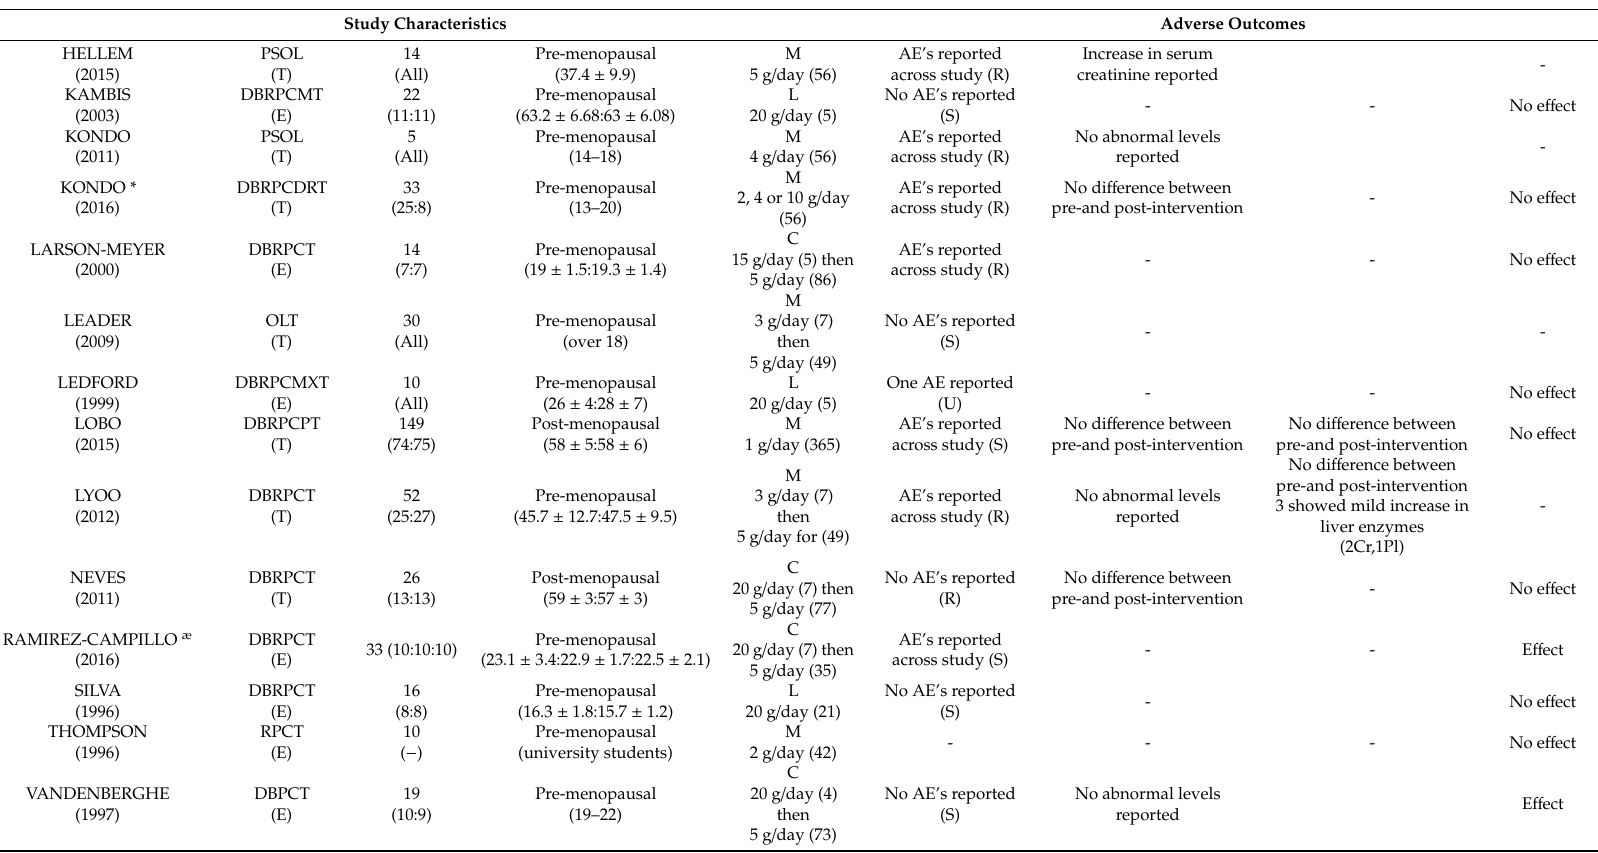
Study Design: DBPCMT = Double blind placebo-controlled matched trial; DBPCT = Double blind placebo-controlled trial; DBRPCDRT = Double blind randomised placebo-controlled dose ranging trial; DBRPCMXT = Double blind randomised placebo-controlled matched crossover trial; DBRPCT = Double blind randomised placebo-controlled trial; DBRPCMT = Double blind randomised placebo-controlled matched trial; DBRPCPT = Double blind randomised placebo-controlled parallel trial; OLT = Open label trial; PSOL = Pilot study open label; RPCT = Randomised placebo-controlled trial; SBRPCMT = Single blind randomised placebo-controlled matched trial; SBRPCT = Single blind randomised placebo-controlled trial. Cr = Creatine group; Pl = Placebo group; E = Ergogenic; T = Therapeutic; M = maintenance dose only; C = Combination loading + maintenance dose, L = Loading dose only; AE = adverse event; Collection method, R = research initiated participant reporting; Collection method, S = participant self-reported; Collection method, U = unknown method of reporting; * 3 arms with di ff erent dosing regimens; æ 3 arms (CrM, Placebo, Control); all = Mean and Standard deviation (SD) presented as total combined age group